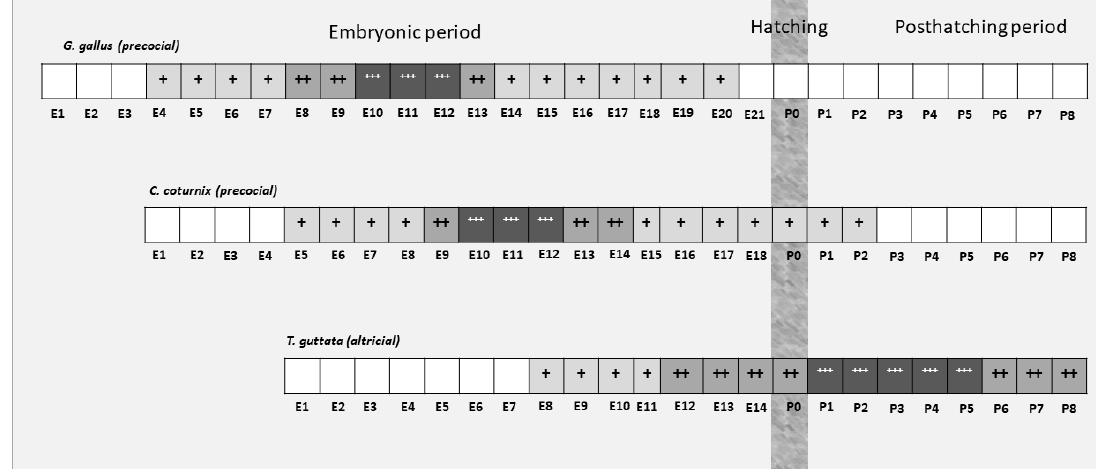
Figure 9. Schematic summary of the chronological patterns and the intensity of neurotrophic cell death in the developing retina of G. gallus [34], C. coturnix [39], and T. guttata (present study). Neurotrophic cell death occurred in the altricial bird at perinatal stages and extended through the first week of life. In contrast, it was restricted to the embryonic period in both of the precocial species. Color codes: white (absence of cell death); light gray (low levels of cell death density) (+); gray (moderate levels of cell death density) (++); dark gray (high levels of cell death density) (+++).